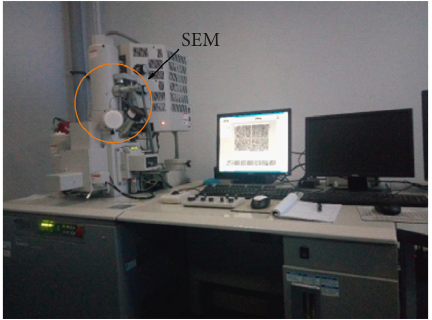
Figure 5: Crack observation equipment. Table 3: Vibration parameters.